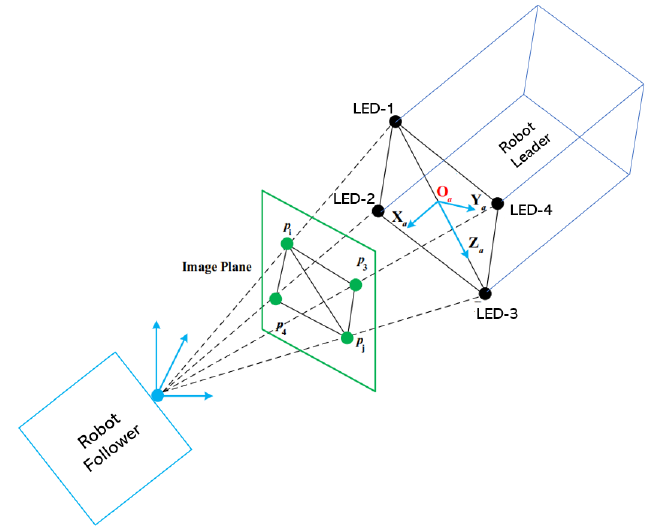
Figure 8. Determination of the relative position of four points using the